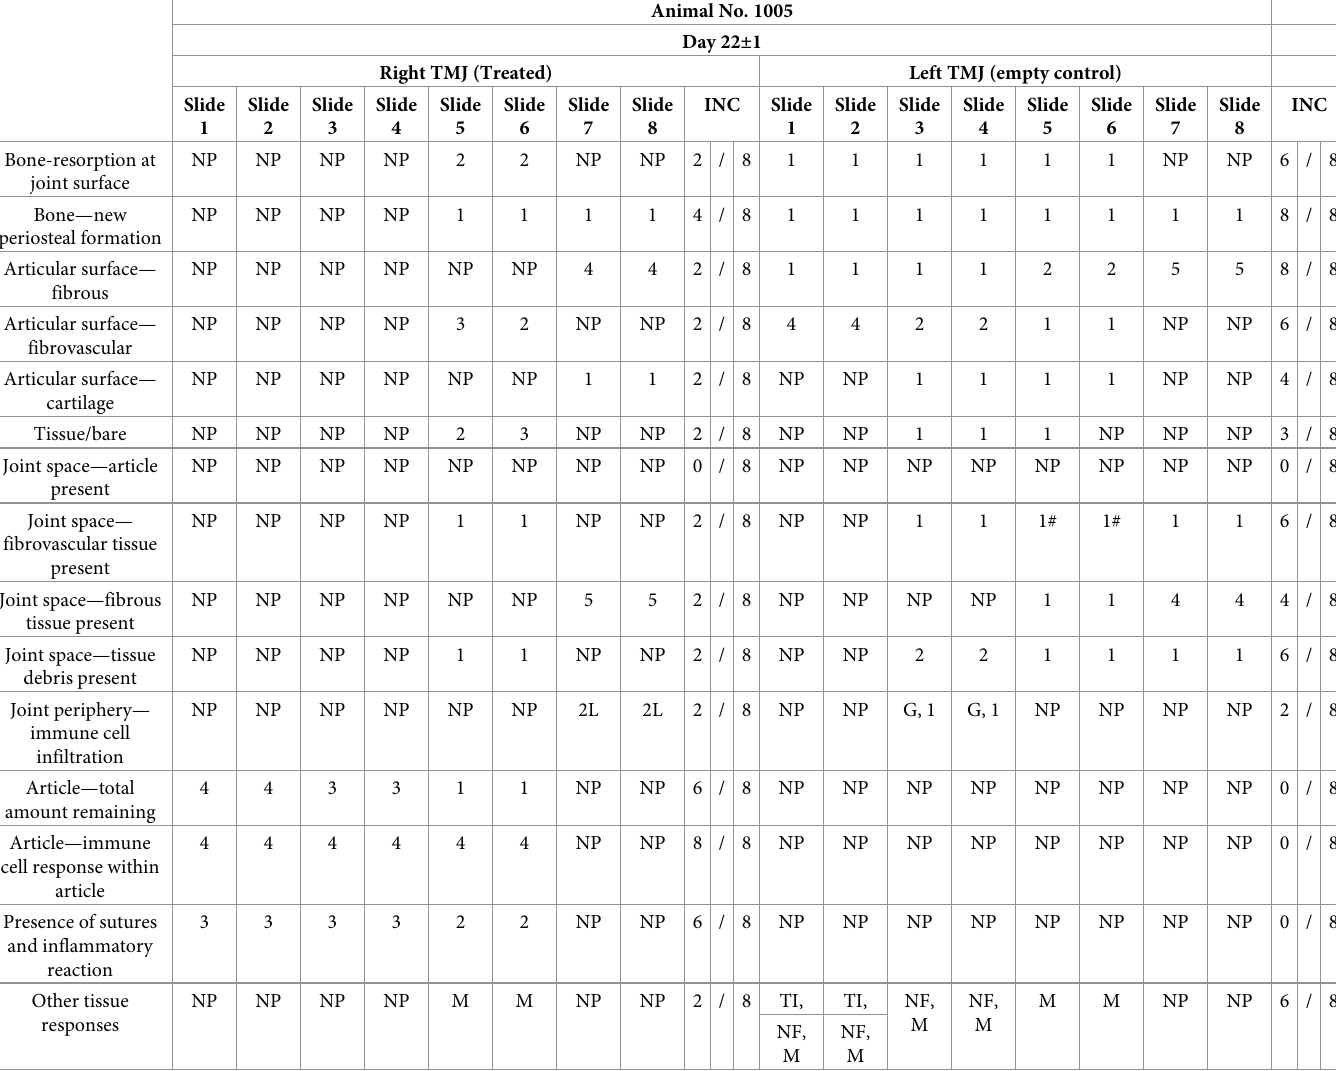
Table 12. Individual histopathological findings for animal